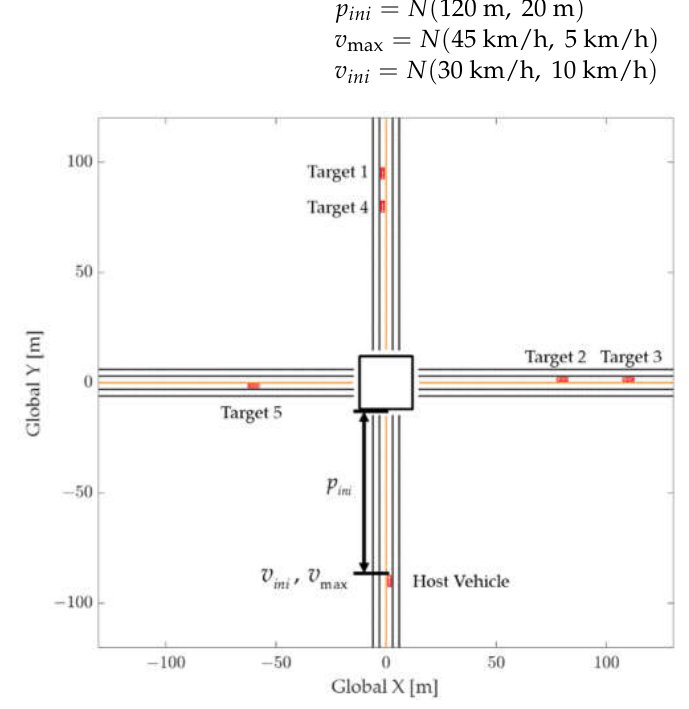
Figure 8. Multitarget intersection scenario.